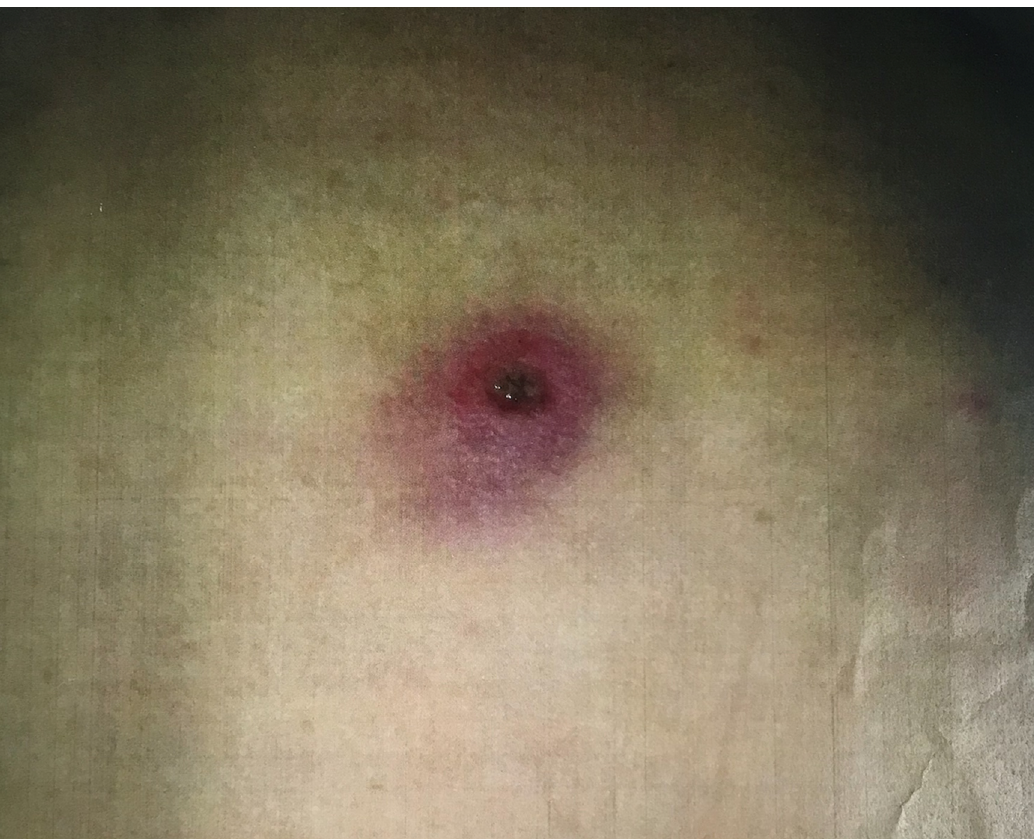
Figure 1. skin lesion with the center developed a black crust covering the ulcer surrounding by an erythematous rim over the right buttock region. erythematous rim over the right buttock